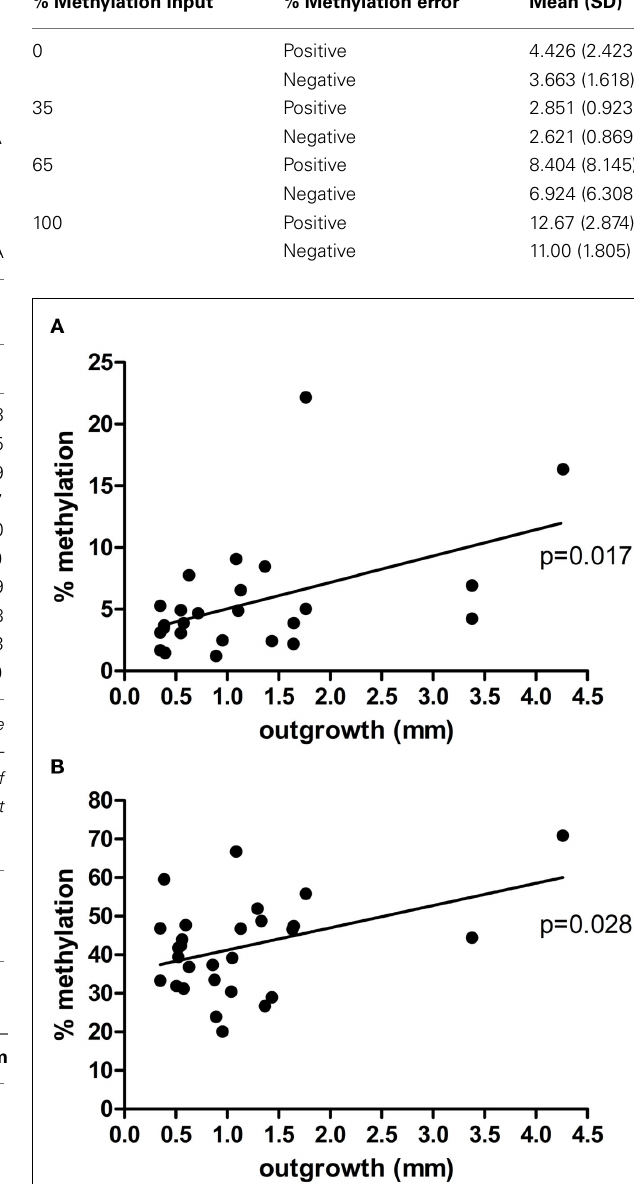
MMP2 was tested in pregnant plasma and compared to non- pregnant plasma samples. PRKCDBP showed low levels of methy- lation in both pregnant and non-pregnant samples (data not shown). The MMP2 promoter showed high methylation levels in non-pregnant plasma samples, which decreased in first trimester samples and further decreased in second trimester ( Figure 2A